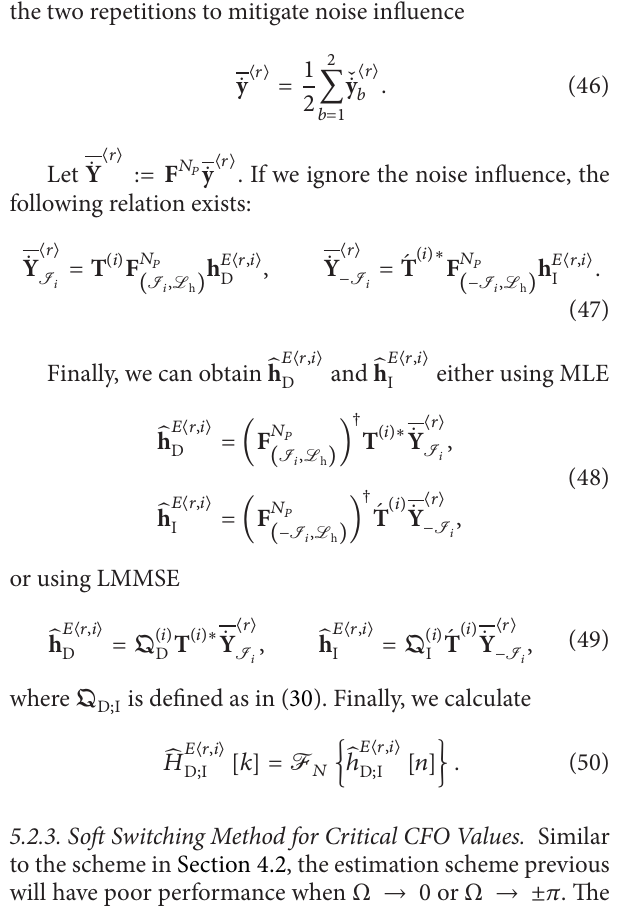
Figure 5. We denote the received preamble sequences after ̌̇ y ⟨𝑟⟩ this compensation as 𝑏 . First, we carry out averaging